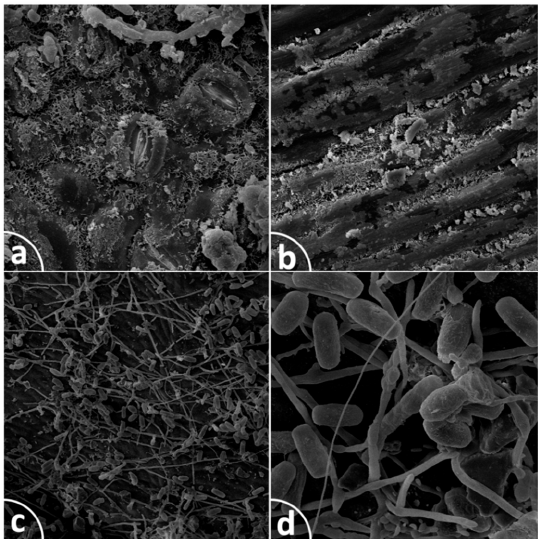
Figure 3. Images of the common oak leaf surface obtained by the scanning electron microscope (SEM): ( a ) a leaf sampled in September with stomatal apparatuses covered with pollution, magnification ×1000; ( b ) a leaf sampled in September with leaf surface erosion, magnification ×1000; ( c ) a leaf sampled in May with the oak powdery mildew mycelium with fresh conidia, magnification ×200; and ( d ) conidia of Microsphaera alphitoides Griff. et Maubl., magnification ×1000.